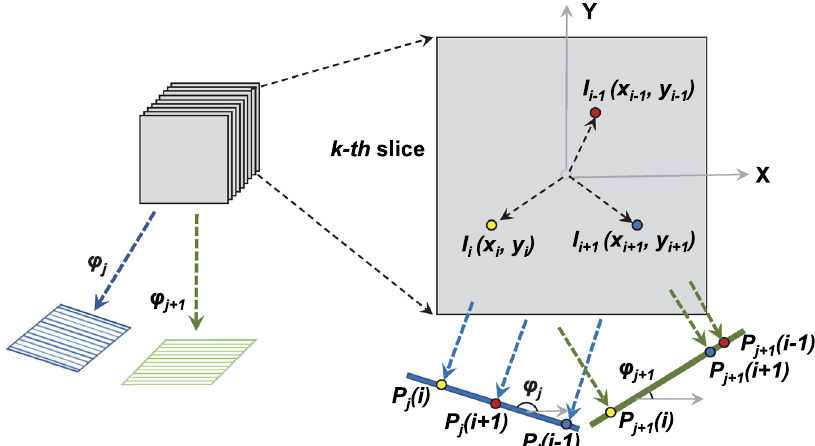
Figure 1. Schematic of the theory of 3D/2D reconstructions from two projections. A 3D object can be treated as a stack of 2D objects, while 3D map projections can be treated as a stack of 1D projection lines from 2D objects along the same projection angle. Given that one 2D object is composited with a total of N k atoms, in the coordinates of ( x i , y i ) or ( r i , θ i ), two projection lines could be sufficient to determine the coordinates of each atom. There is no requirement regarding how large the angle between two projection angles needs to